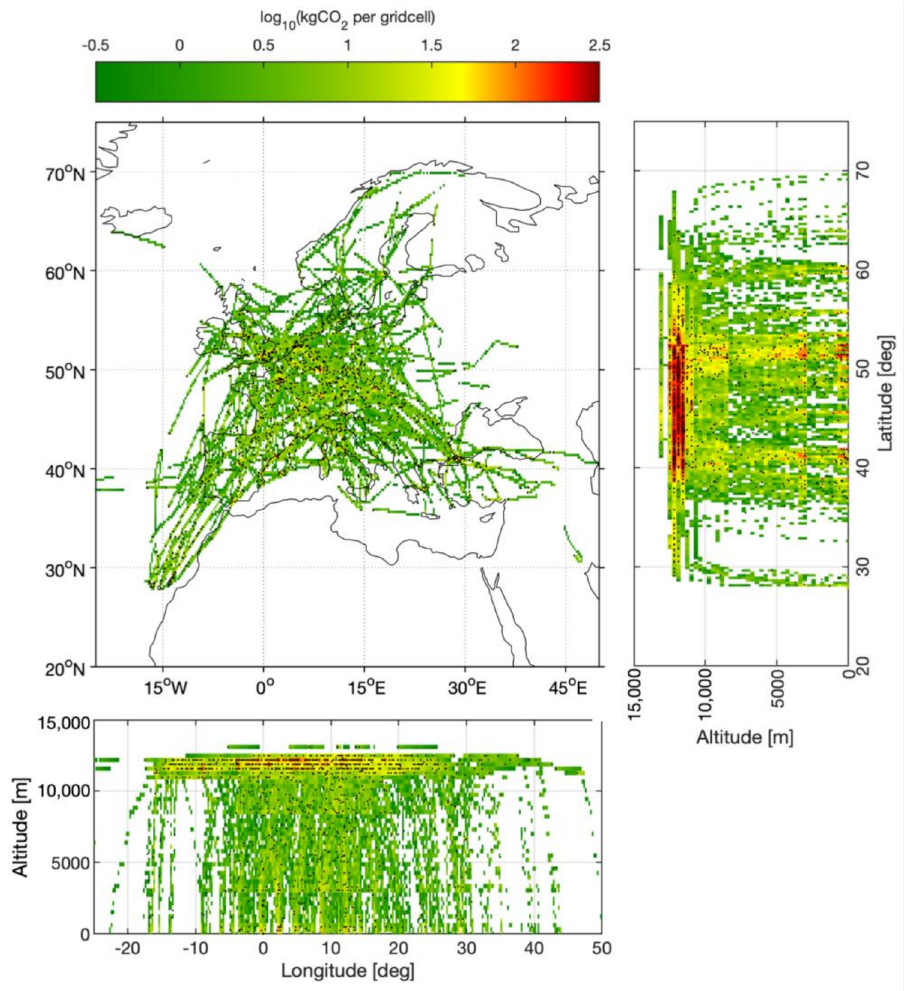
Figure 4. Cumulative CO 2 emission distributions of the chosen reference traffic on 18 December 2015, between 11.30 a.m. and 12.00 p.m. UTC as function of latitude and longitude (top left), altitude and latitude (top right) as well as altitude and longitude (bottom). Black dots indicate aircraft positions at 12.00 pm